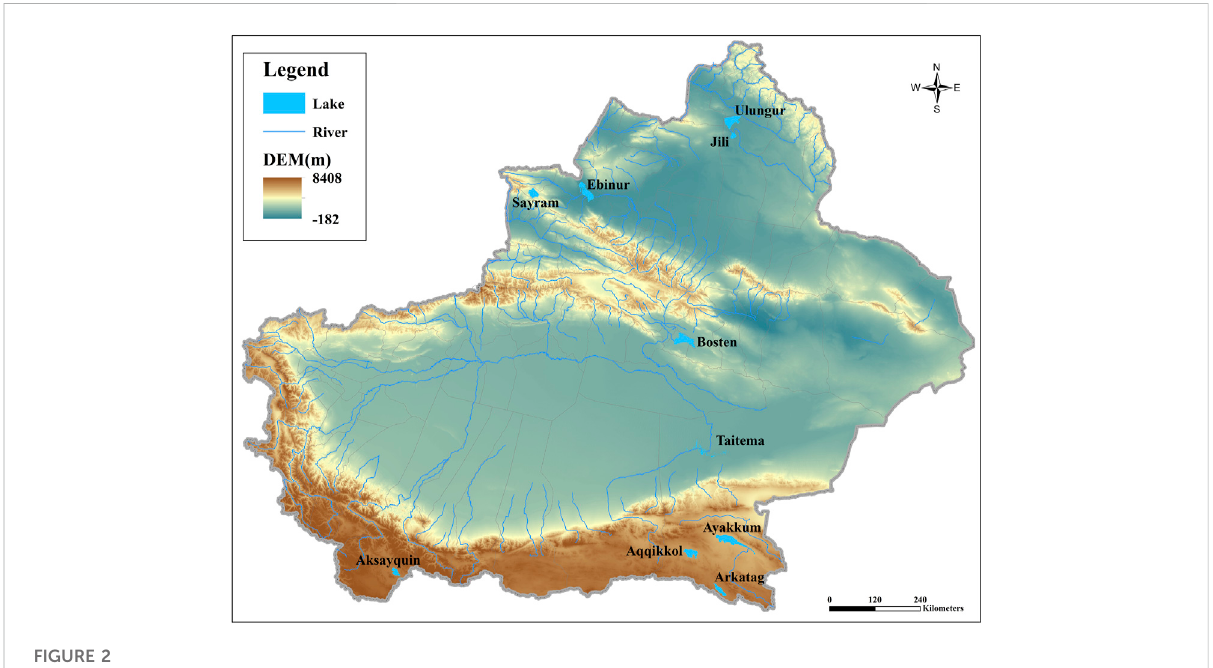
FIGURE 2 Distribution of typical lakes in